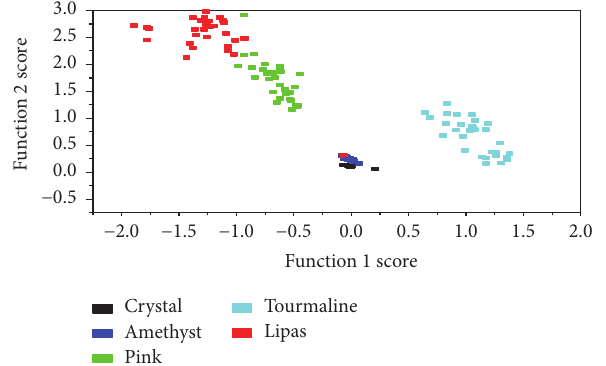
Figure 5: Plot showing the comparison between function score 1 and function score 2.